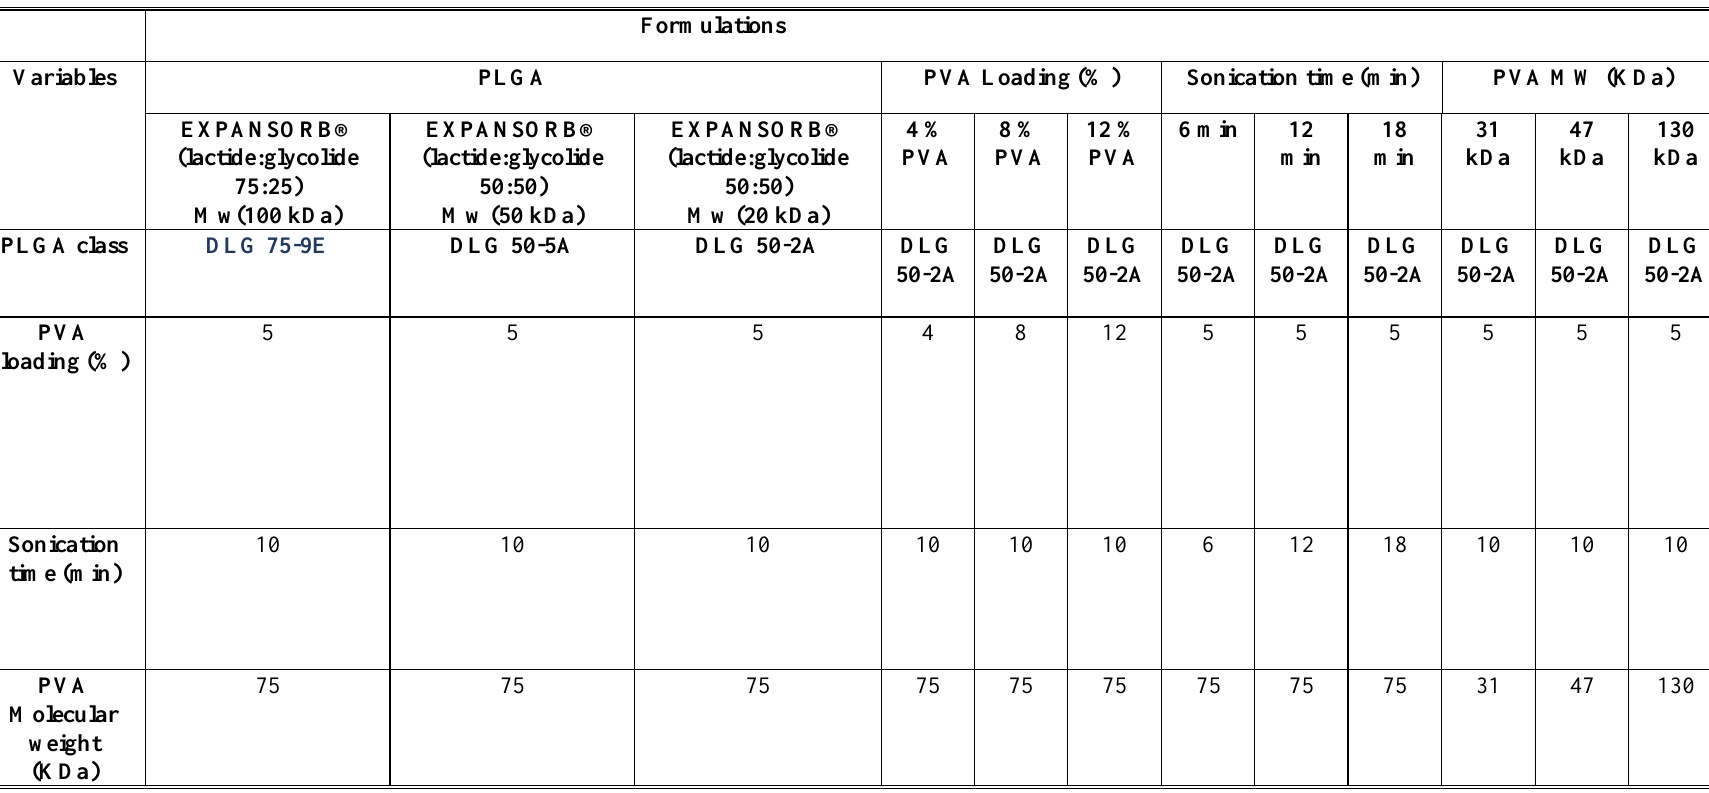
Table 1.The formulation variables and sonication times of the 10% w/w 5-FU loaded poly lactic-co-glycolic acid nanoparticles. The shaded areas indicate the parameter that was varied for that particular group of